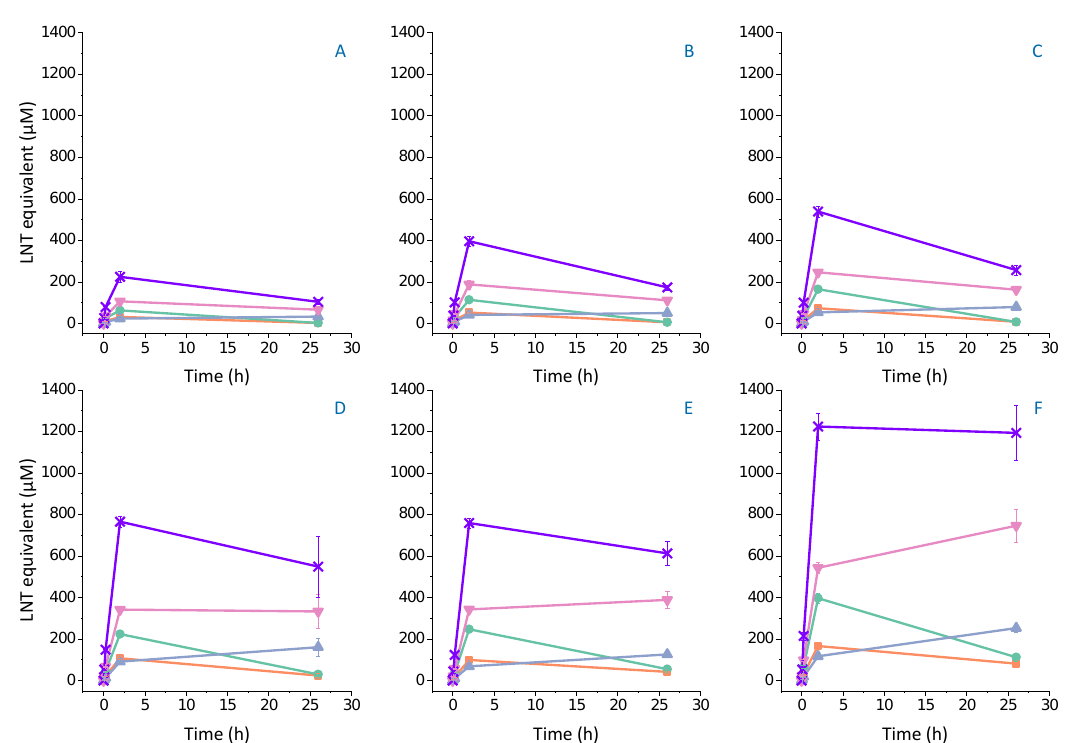
Figure 10. Transglycosylation reactions using pNP-LNB as donor and lactose as acceptor at pH 4.5 and 30 °C for LnbB W394H and varying substrate initial concentrations. ( A ): 2.5 mM pNP-LNB, 200 mM lactose; ( B ): 2.5 mM pNP-LNB, 400 mM lactose; ( C ): 5 mM pNP-LNB, 200 mM lactose; ( D ): 5 mM pNP-LNB, 400 mM lactose; ( E ): 10 mM pNP-LNB, 200 mM lactose; and ( F ): 10 mM pNP-LNB, 400 mM lactose. The formation of transglycosylation products was followed over 26 h and quantified as LNT equivalents. Purple crosses represent the total formation of all LNT isomers, while pink triangles represent the formation of LNT (LNB- β 1,3-Lac), orange squares LNB- β 1,2-Lac, green circles LNB-1,1-Lac, and blue triangles LNB- β 1,6-Lac.